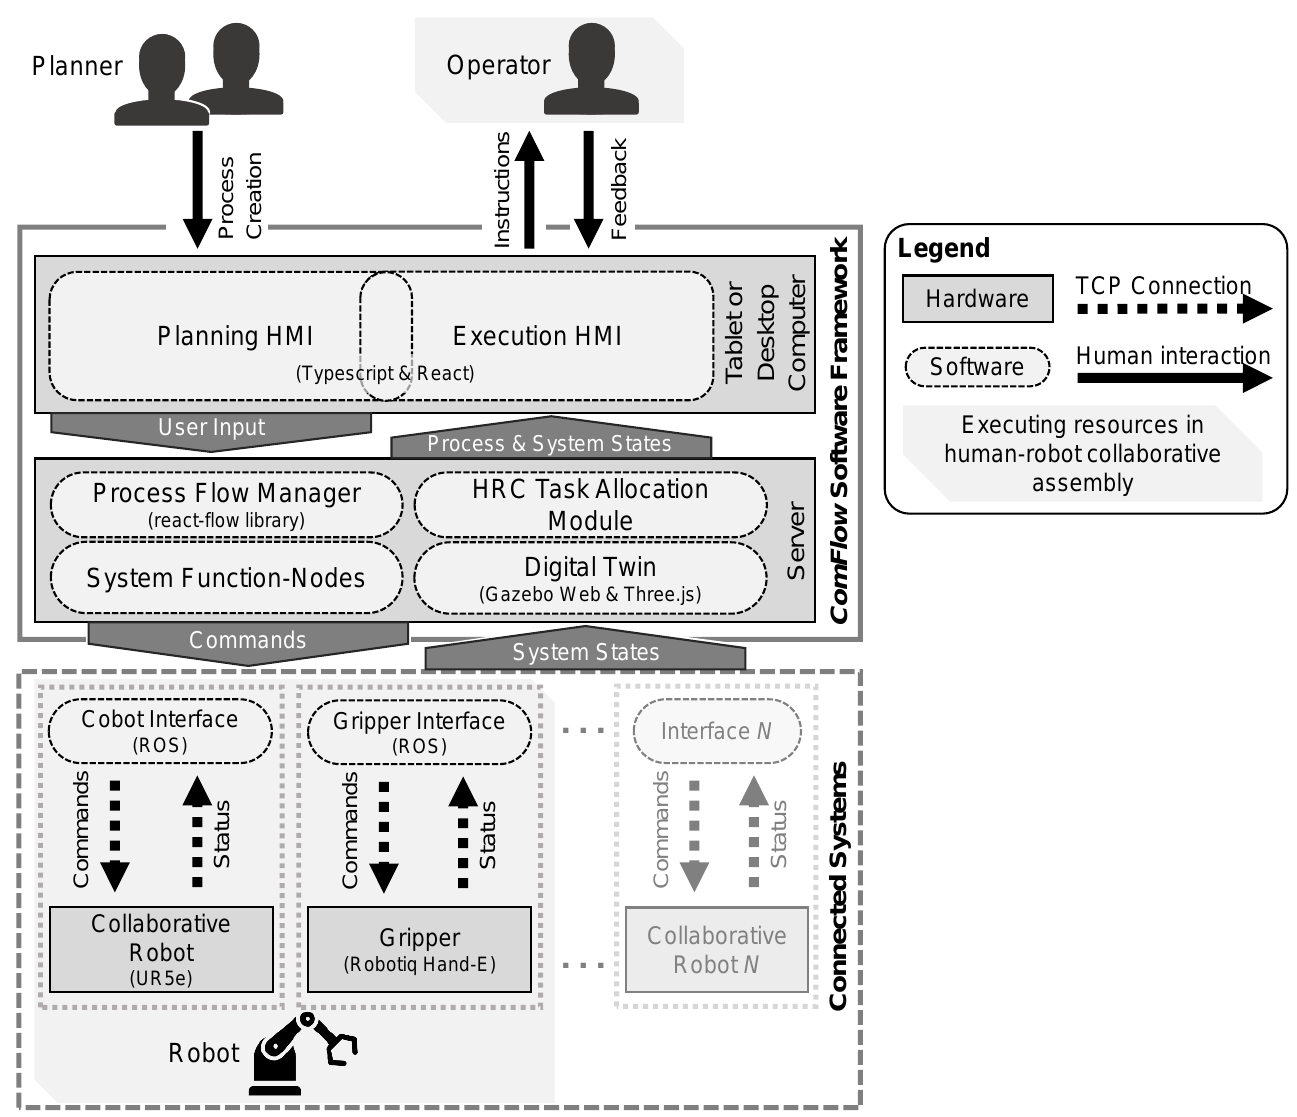
Figure 3. System architecture of the software framework ComFlow for block-based no-code programming with integration of the task allocation module and the specific hardware setup within this article for enabling human – robot collaborative assembly (extended and adapted based on [47]).